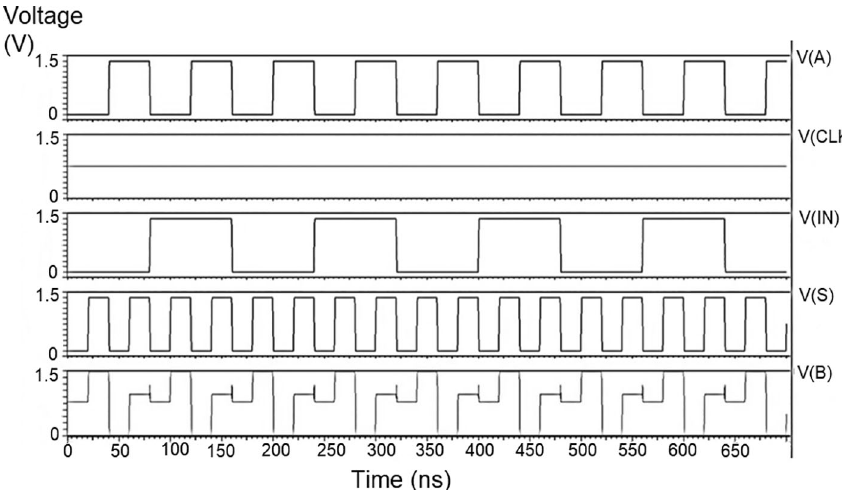
Figure 7(c). Voltage vs time simulation at 1.5 V for 180